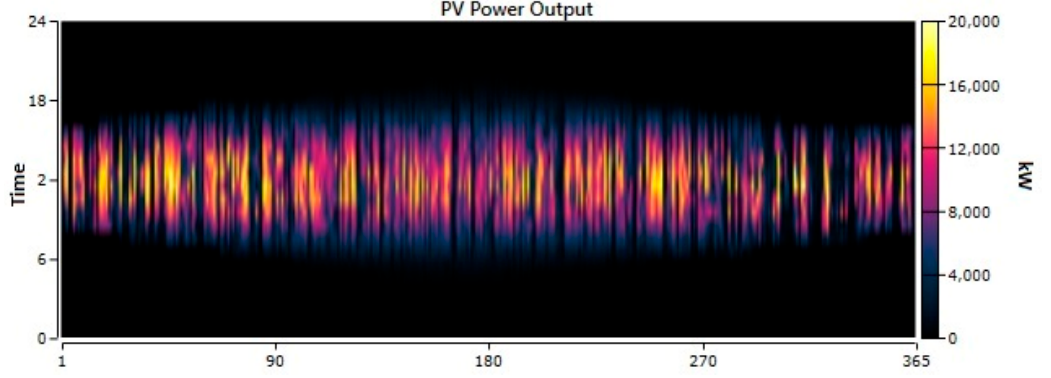
Figure 6. PV electricity generation during daytime throughout the year .